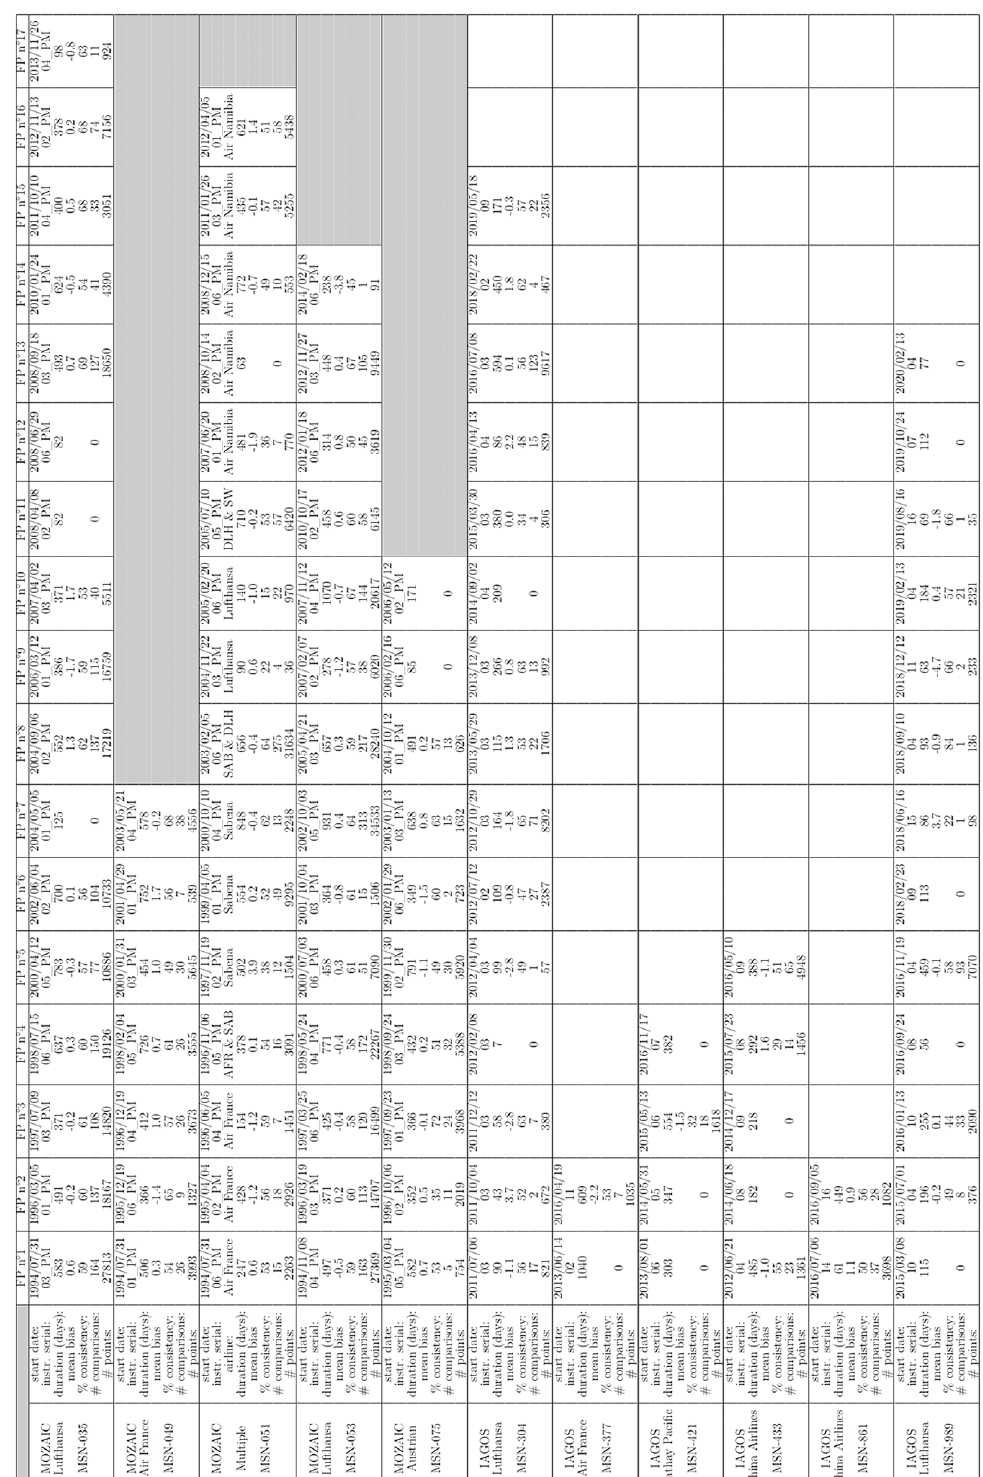
Table 4. Table compiling all the MOZAIC and IAGOS flight intercomparisons O 3 measurement statistics and information for each instru- ment’s FP. The latter are gathered and enumerated per aircraft. “Start date” is the date of the instrument unit installation on the aircraft (start of the flight period), “instr. serial” is the serial number of the instrument unit, “duration” is the length of the flight period in days; for “mean bias” and “% consistency”, see Sect. 4.2 for explanation. “No. comparisons” and “no. points” are the number of collocated profiles and collocated data points found according to the methodology described in Sect.